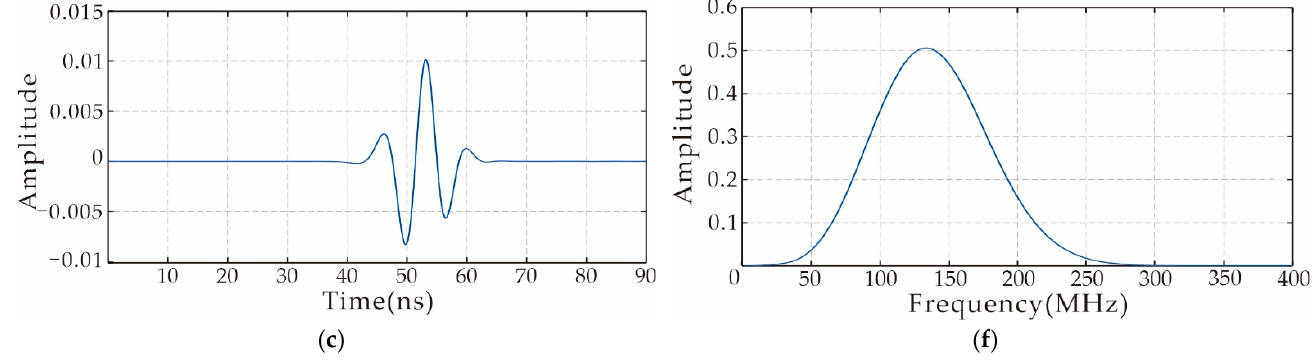
Figure 2. Convolutional spectrum analysis. ( a ) Source wavelet of real data: center frequency 100 MH and corresponding ( d ) spectrum; ( b ) source wavelet used in the forward modeling: center frequency 140 MHz and corresponding ( e ) spectrum; ( c ) a certain residual field source and the corresponding ( f ) spectrum.